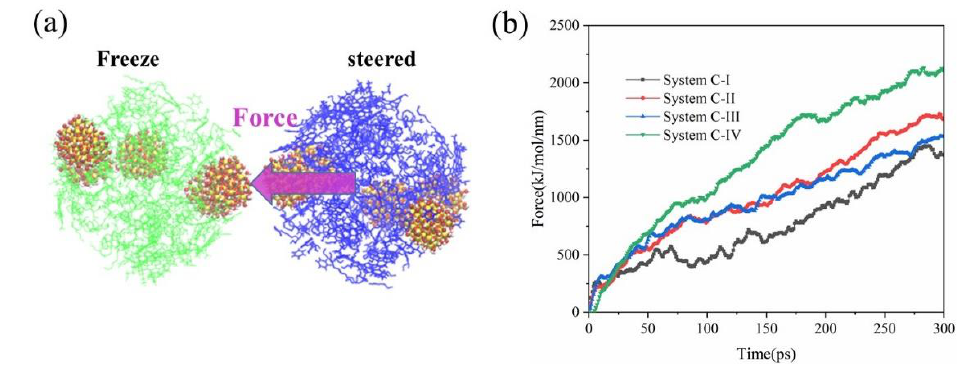
Figure 11. Schematic of the steered structure ( a ), force parameters during the steering ( b